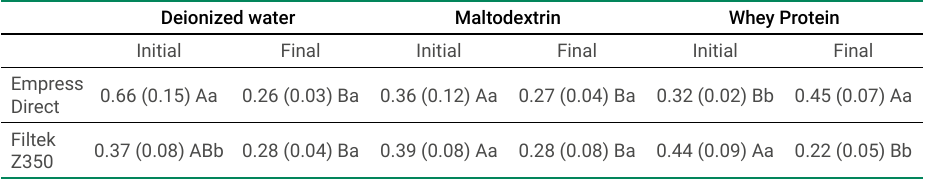
*Different lower-case letters in the columns and upper-case letters in the rows indicate statistically significant differences (p<0.05).